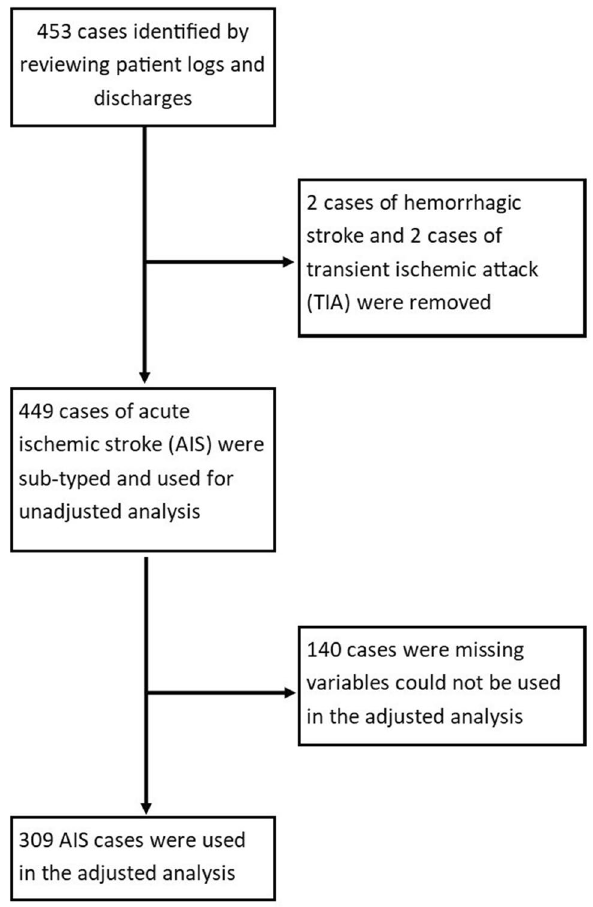
Figure 1. Flowsheet of AIS cases identified in patients aged 18–49 that were used in adjusted and unadjusted Unadjusted analysis. In the unadjusted analysis, the vascular group (combined lacunar and LAA sub- types) had significantly higher association with hypertension, DM, smoking by pack-years, and intracranial atherosclerosis, and higher systolic blood pressure, diastolic blood pressure, admission glucose, HbA1c, LDL cholesterol, and triglycerides as compared to the CE subgroup (Table 2). The CE subgroup, on the other hand, had a significantly higher association with congestive heart failure, rheumatic heart disease, atrial fibrillation, clinically significant clotting disorders, left ventricular hypertrophy, lower ejection fraction, higher left atrial size, higher pro-BNP and higher mean troponin level as compared to the vascular group (Table 2). There were no significant differences in the presence of patent foramen ovale (PFO) or HDL. Adjusted analysis. In the adjusted analysis, we compared the vascular (aggregated lacunar and LAA) and